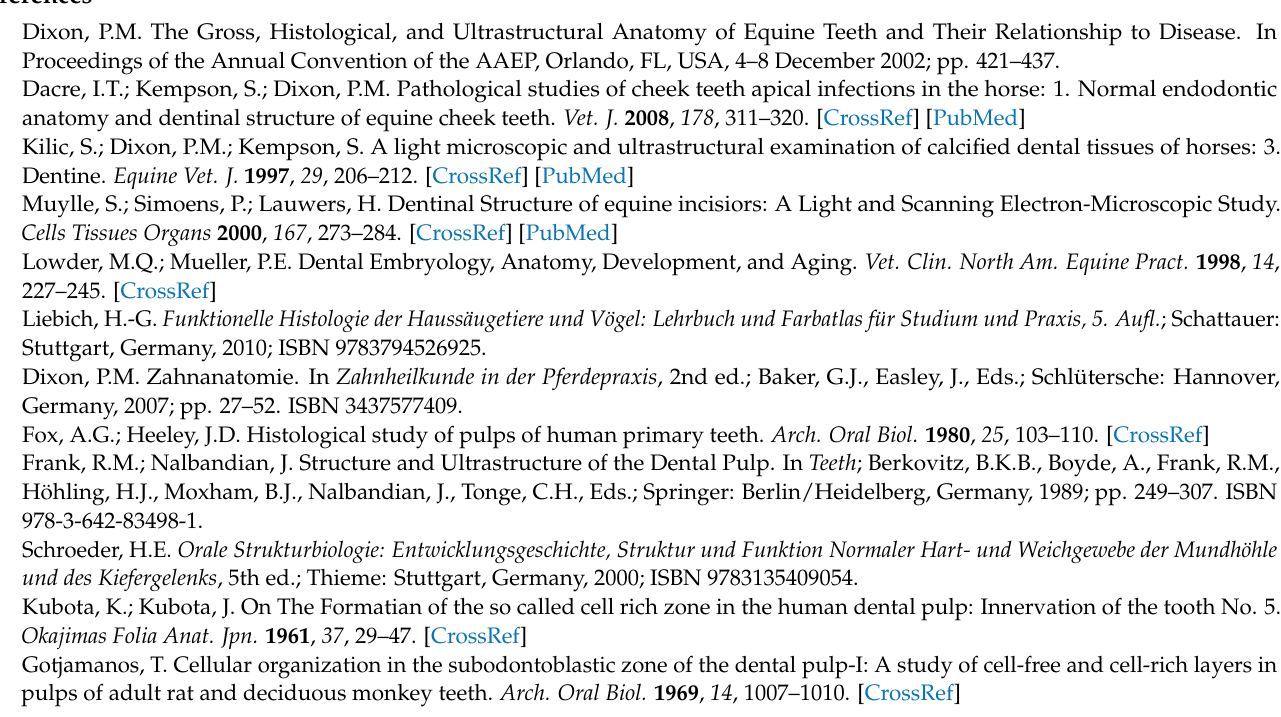
(AG 1 to 3); Table S3. Additional statistical significances of fibroblastic cell nuclei per 2000 µ m 2 in incisors and cheek teeth regarding different age groups (AG) within the defined zones (1.a to 4); Table S3.1 Additional statistical significances of fibroblastic cell nuclei per 2000 µ m 2 in incisors and cheek teeth, regarding different horizontal levels so (subocclusal), c (central), and a (apical) within the age groups (AG 1 to 3); Table S3.2 Additional statistical significances of fibroblastic cell nuclei per 2000 µ m 2 in incisors and cheek teeth, regarding the defined zones (1.a to 4) within the age groups (AG 1 to 3); Table S3.3 Additional detailed statistical significances of fibroblastic cell nuclei per 2000 µ m 2 in incisors and cheek teeth, regarding the defined zones (1.a to 4) within specific horizontal level ( so , c , a